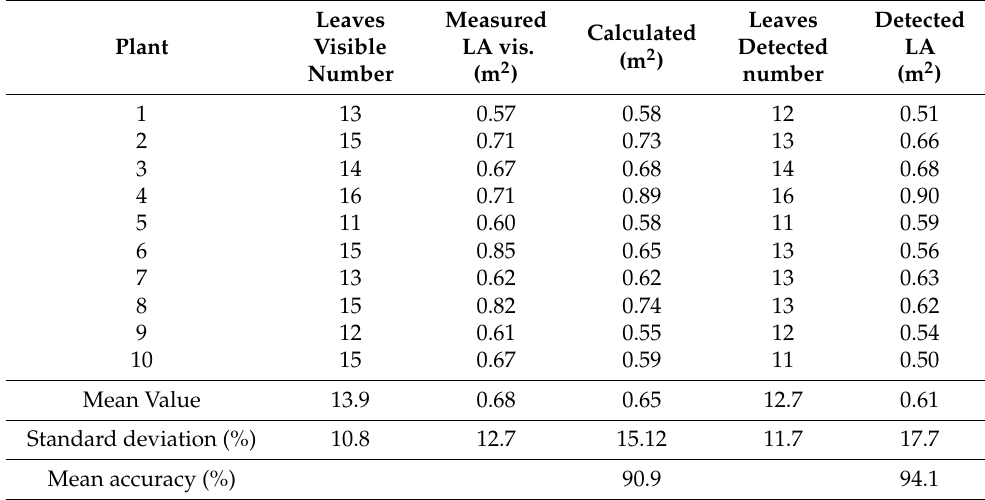
Table 4. BBCH 48: Comparison of measured, calculated (calc.), and detected leaf area and the mean accuracy (MA) of the visible leaves (vis.).